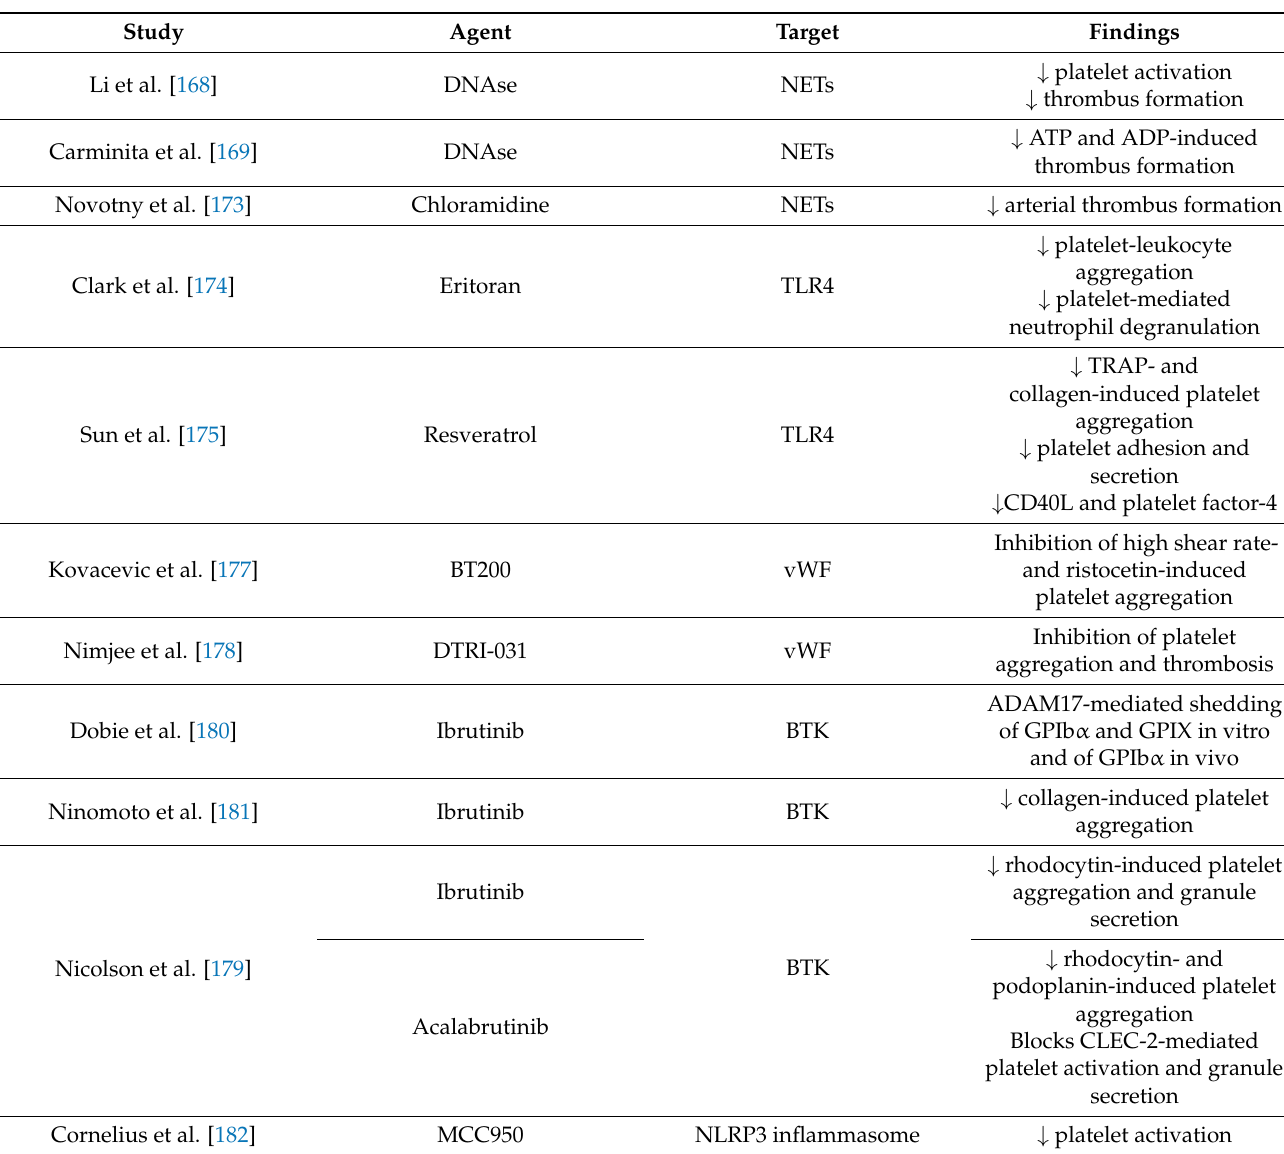
Table 2. Studies evaluating the effect of the experimental anti-inflammatory agents on thromboinflammation.